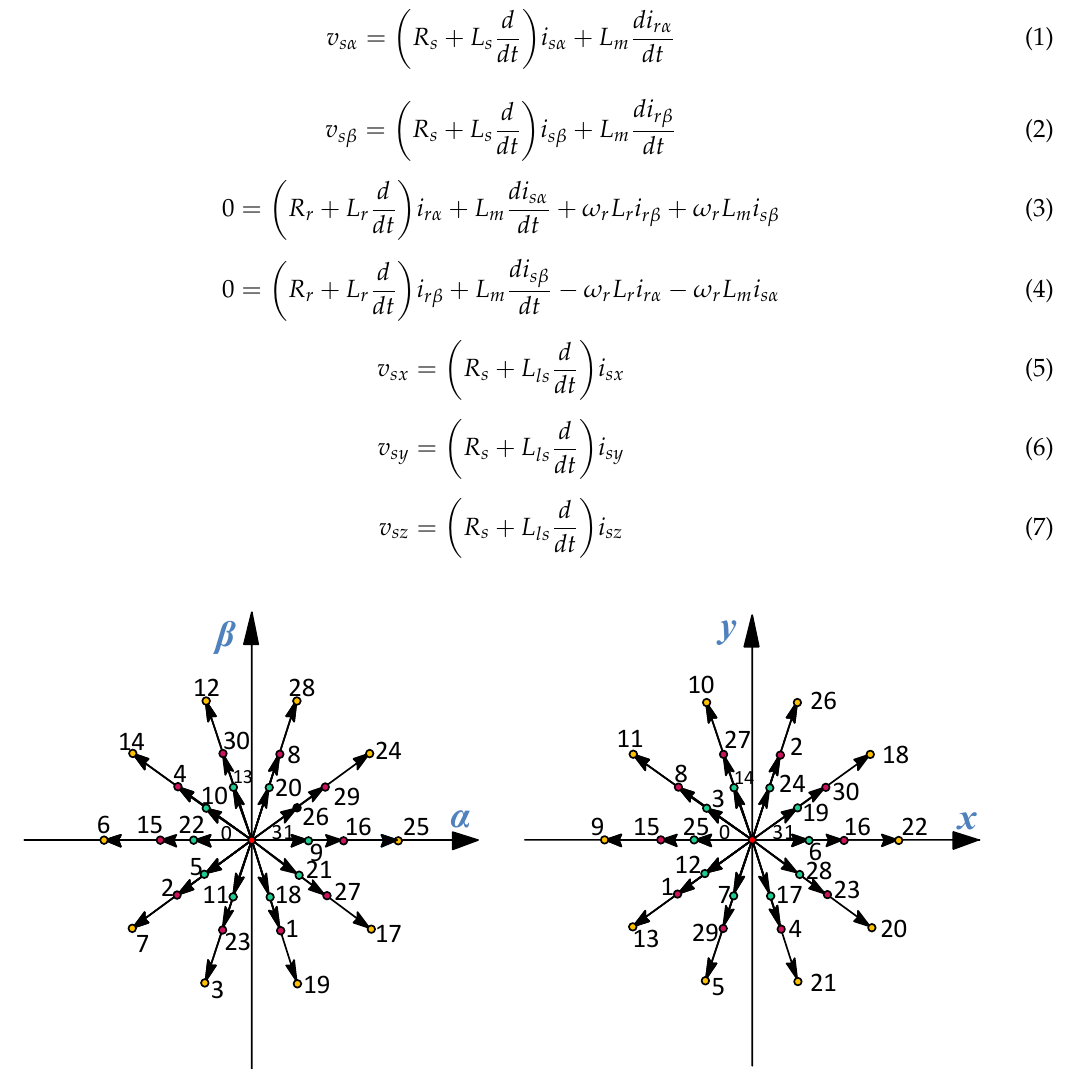
Figure 2. Generated voltage vectors in the α - β and x - y planes. Note that the same switching state produces two different vectors in every plane.